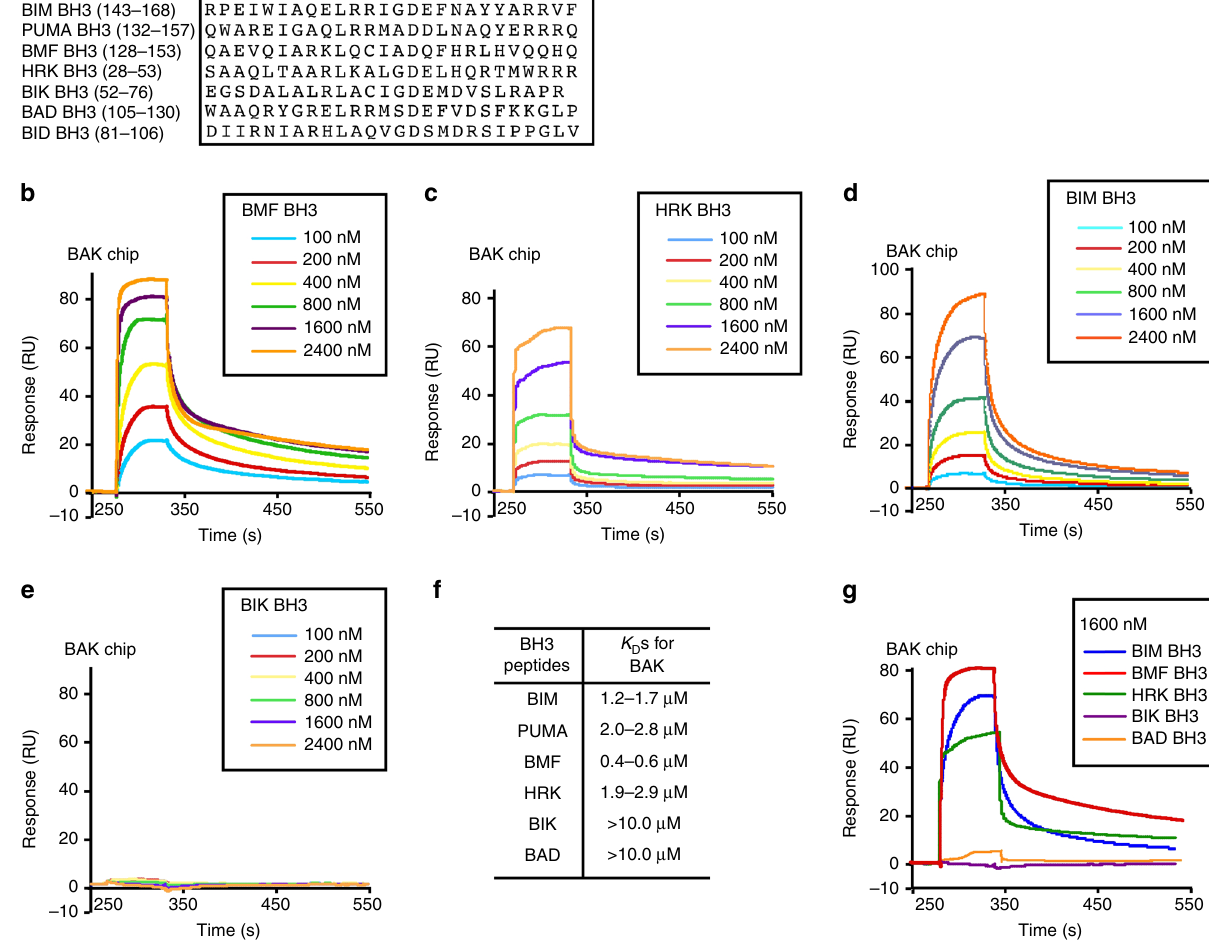
Fig. 1 Direct interaction of BMF and HRK BH3 peptides with BAK Δ TM. a Synthetic BH3 peptides used in this study. b – e SPR (relative units (RU)) observed when immobilized BAK Δ TM was exposed to a series of concentrations of BMF BH3 b , HRK BH3 c , BIM BH3 d , or BIK BH3 e . f Approximate dissociation constant ranges of BAK Δ TM interacting with the indicated BH3 peptides estimated from three independent SPR assays using steady-state analysis (Supplementary Fig. 1). Because artefacts were observed when high concentration of certain peptides were applied, the determination of BAK:BH3 peptide af fi nities did not meet the criterion required for steady-state analysis that top concentrations should be at least threefold above the reported K D . g Direct comparison of BAK Δ TM interacting with the indicated BH3 peptides at 1600 nM. K D dissociation constant. Source data are provided as a source data fi